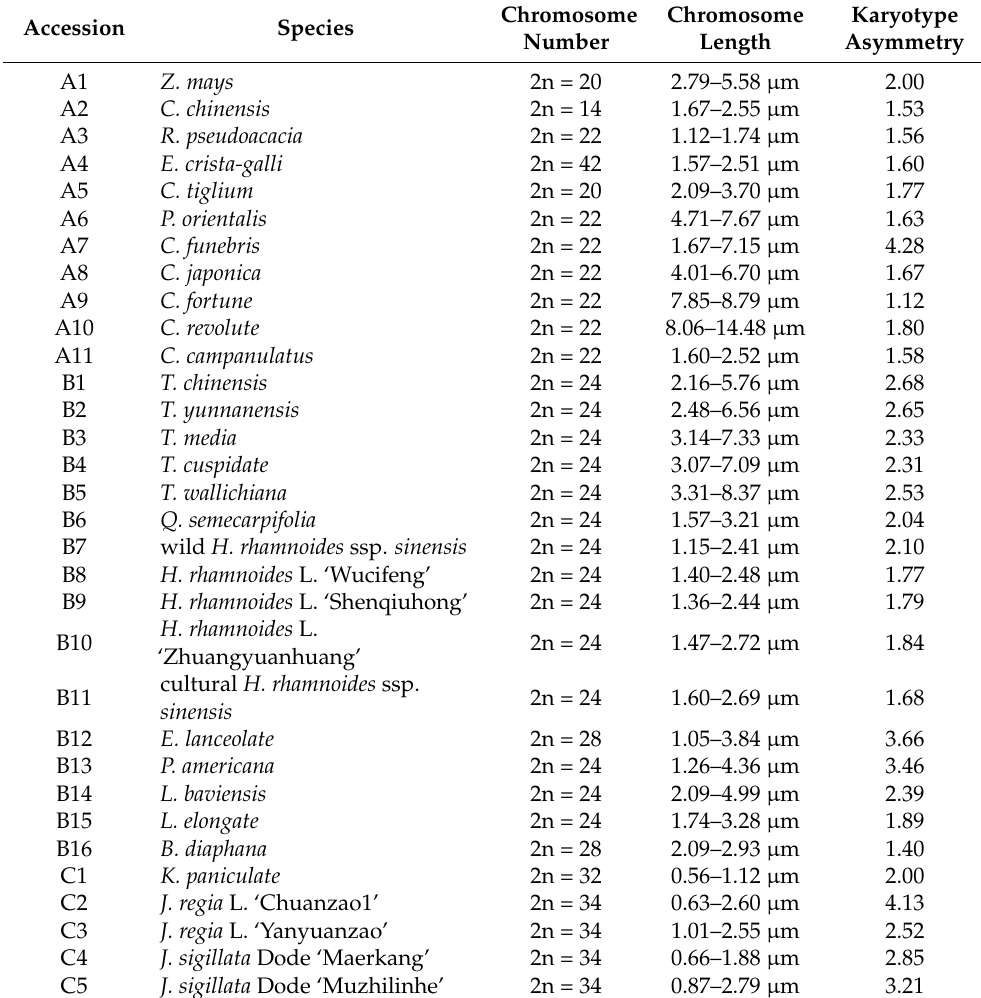
Table 2. Chromosome number and length of the 42 plants used in this